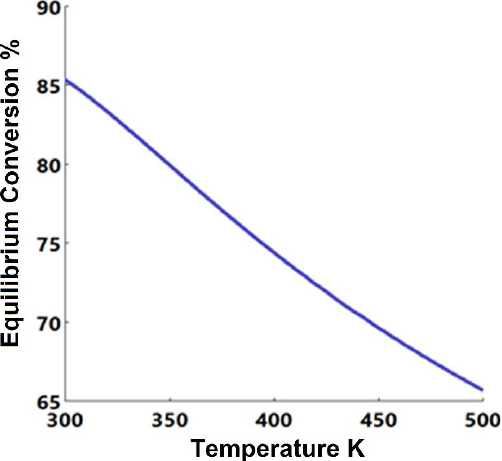
Figure 1. Equilibrium conversion of n -butanol vs. reaction temperature for the esterification reaction.